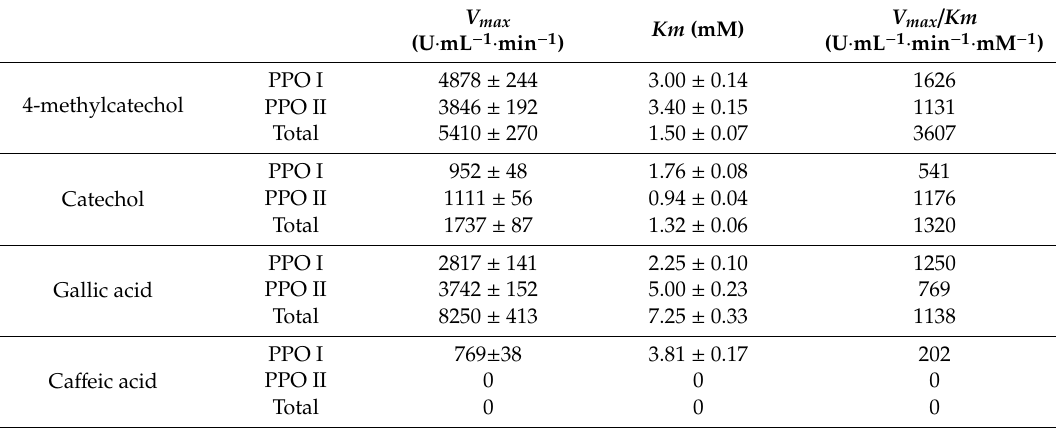
Table 2. Kinetic parameters of PPOs from lentil sprouts assessed with the use of several phenol